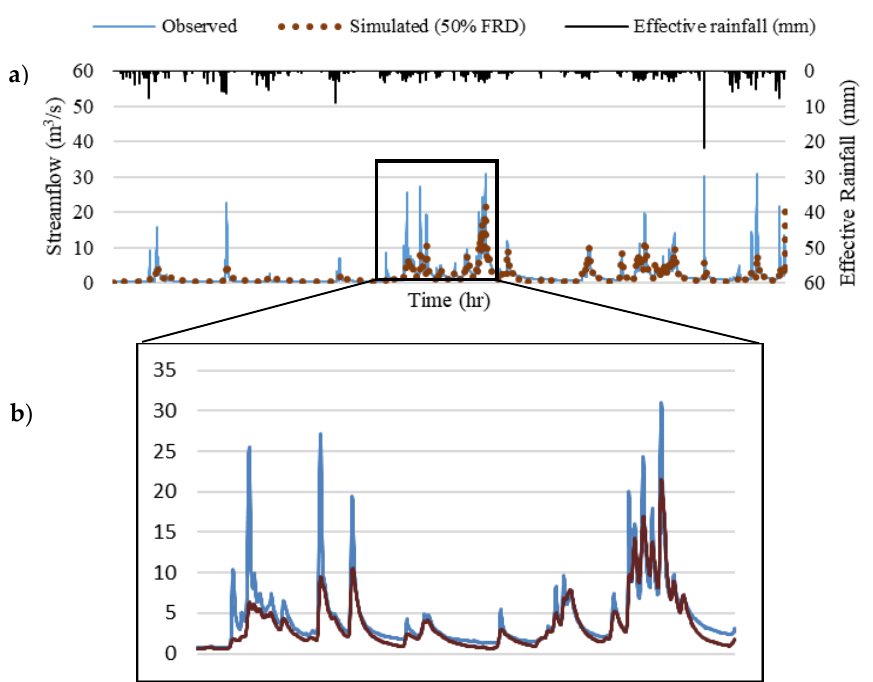
Figure 6. ( a ) Validation of the calibrated 50%-FRD model; ( b ) zoomed in for a clear view.